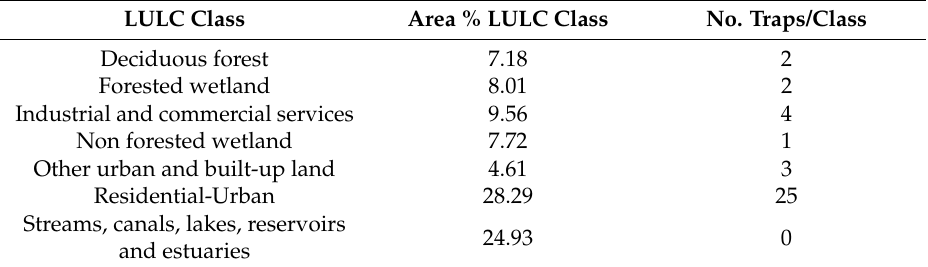
Table 2. Number of traps and area percentage of LULC classes within 5-km buffer radii in